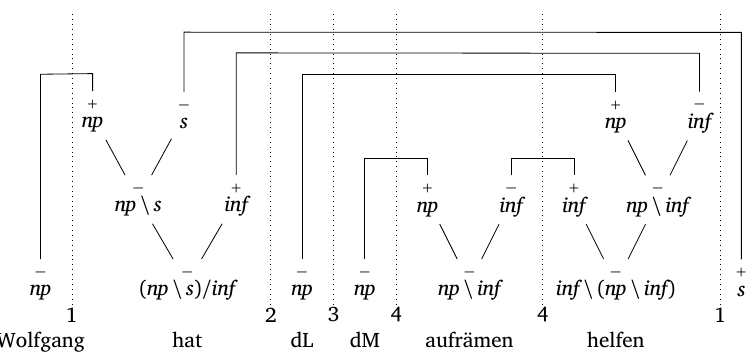
Figure 5: Proof net for “Wolfgang